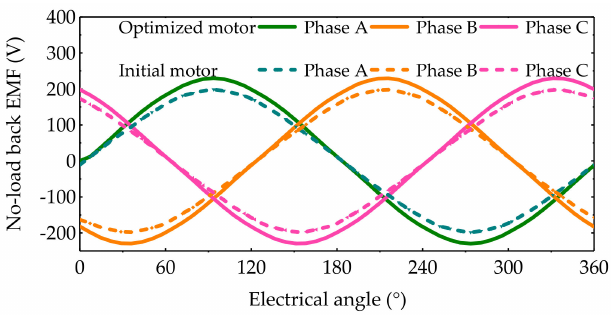
Figure 11. The no-load back-EMF of the initial motor and the optimized motor.